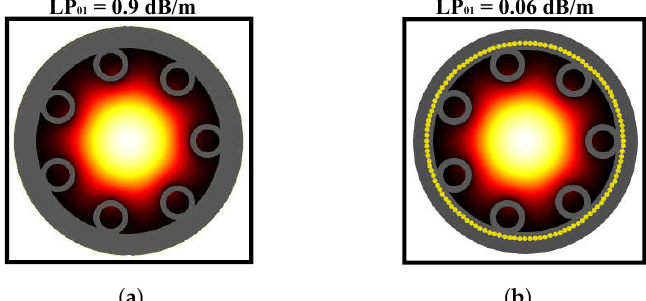
Figure 6. Simulated intensity distributions and confinement loss of the LP 01 -like fundamental mode in air-core when D / D c = 0.2 for ( a ) AR fiber with metal wire inclusions; ( b ) AR fiber without metal wire inclusions at 1 THz. All AR fibers with 140 metal-wire inclusions have a uniform wire diameter d = 90 µ m and fixed thickness between aluminum wire and inner dielectric cladding layer p = 289 µ